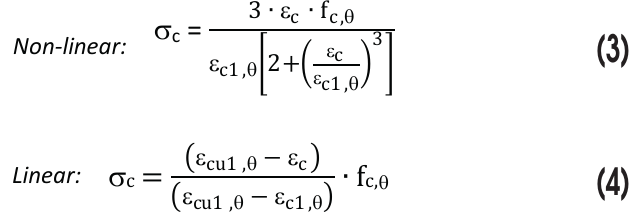
n dashed line: k applicable when ε < 2%, usually compressive s,θ si reinforcement of columns, beams or slabs.Reference: ABNT